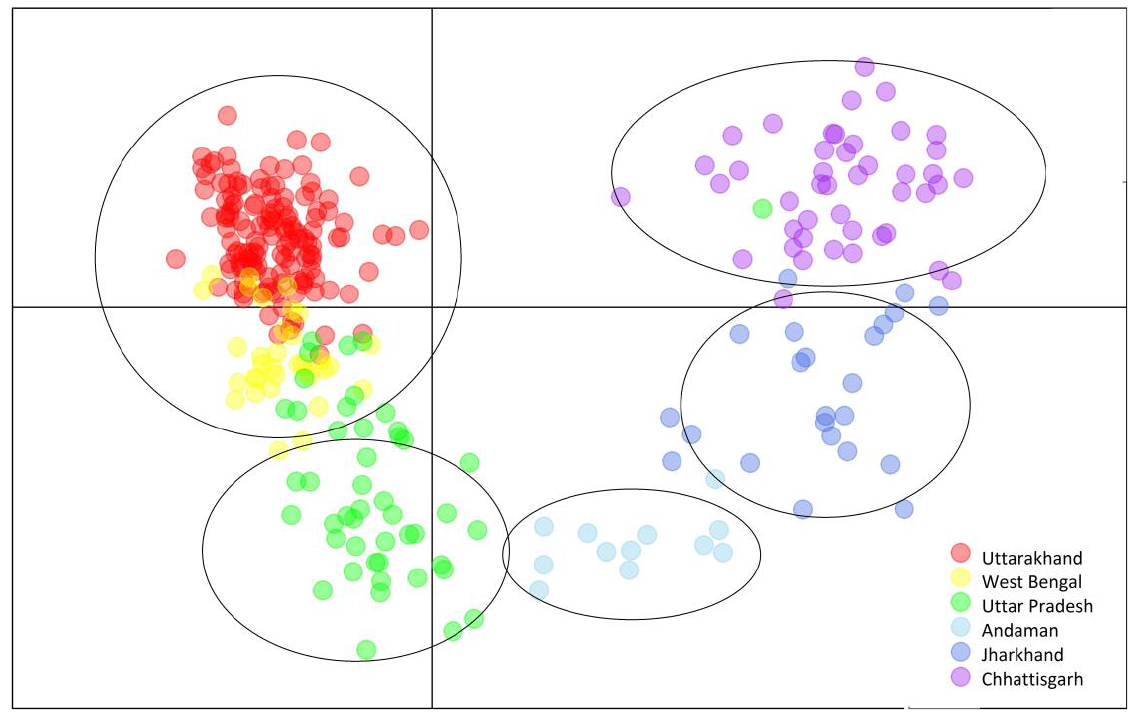
Figure 5. Discriminant analysis of principal components (DAPC) plot of 298 rice landraces showing five clusters with SSR